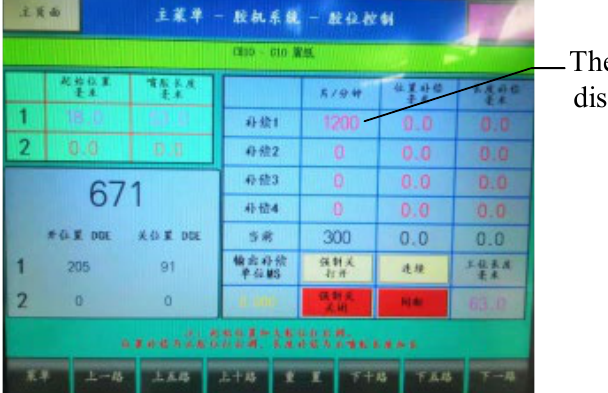
Figure 20. Optimized transverse device (side).